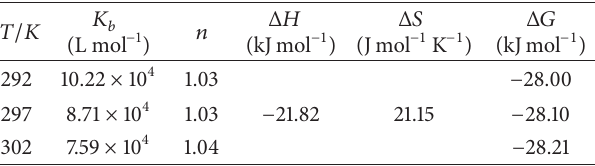
Table2:BindingconstantsandthermodynamicparametersofBSA- TRES interaction at different temperatures.